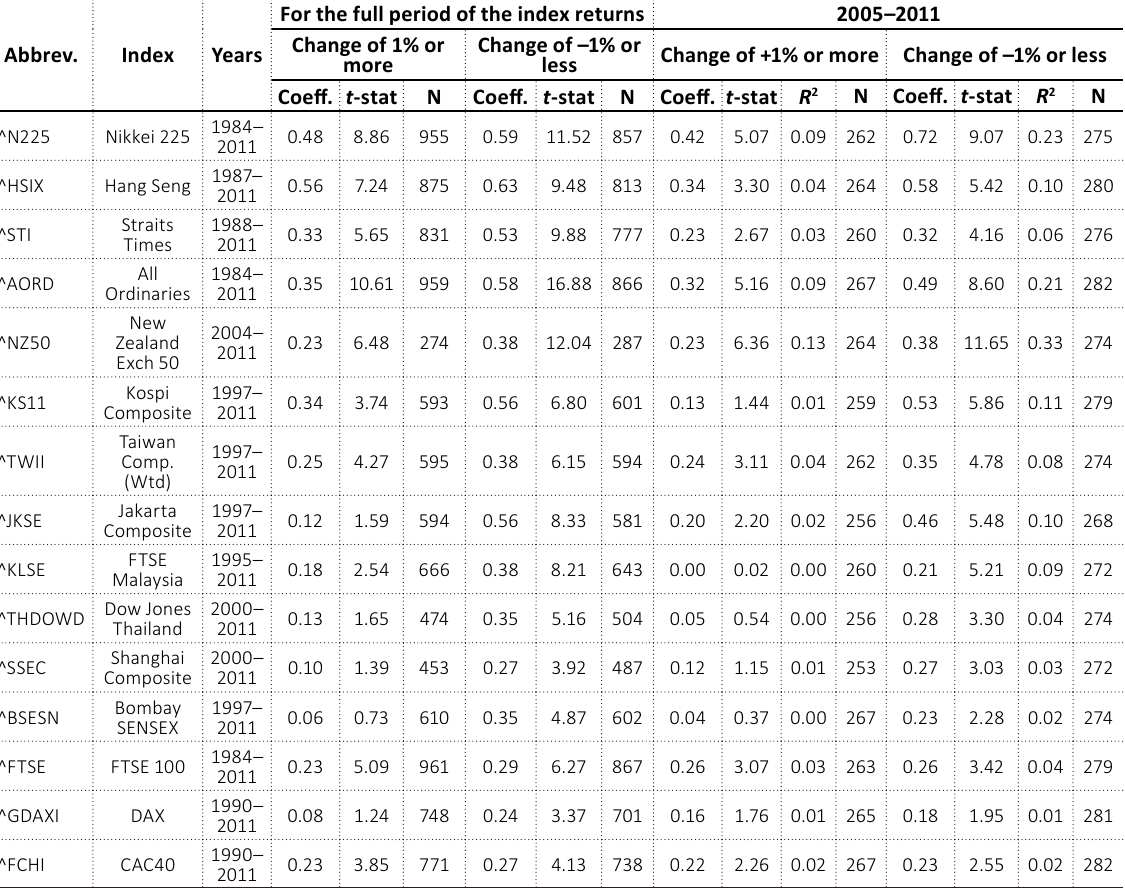
0.01, and the negative return coefficient is 0.53 (and significant) with an R -square of 0.11. The coefficient for negative changes from Table 5 is higher than the combined sample coefficient in Table 3. To sum up the Table 5 findings, the down-market reactions are stronger than the up-market reac- tions in all the Asian-Pacific markets. For 2005- 2011 the average coefficient in down-markets for the eleven Asia-Pacific nations is 0.42, exactly double the coefficient of 0.21 in up-markets. Thus, Hypothesis 4 (that the upward moves in Asian- Pacific equity markets following a move up in U.S. equity markets are symmetric to the down- ward moves in these markets) may be rejected. Compared to the “average” reaction to all changes shown in Table 3 for 2005–2011, the reactions to positive changes shown in Table 5 are all far lower and the reaction to negative changes show a mix of higher and lower values.